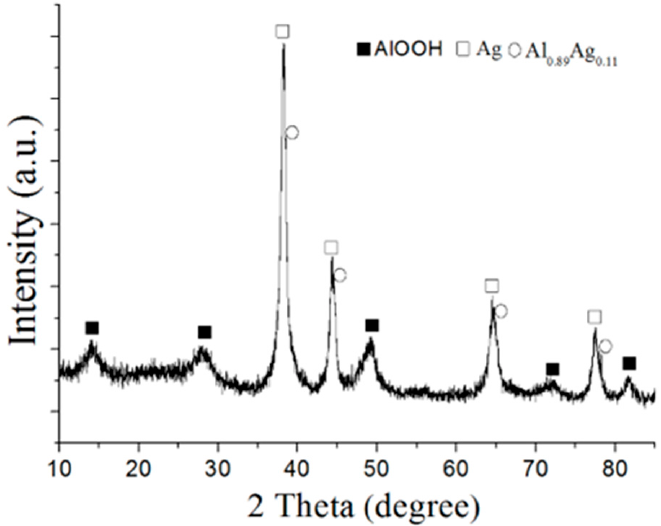
Figure 4. XRD pattern of the nanoscale structures obtained through the water oxidation of Al/Ag nanoparticles at 80% RH at 60 ° С (sample 1).